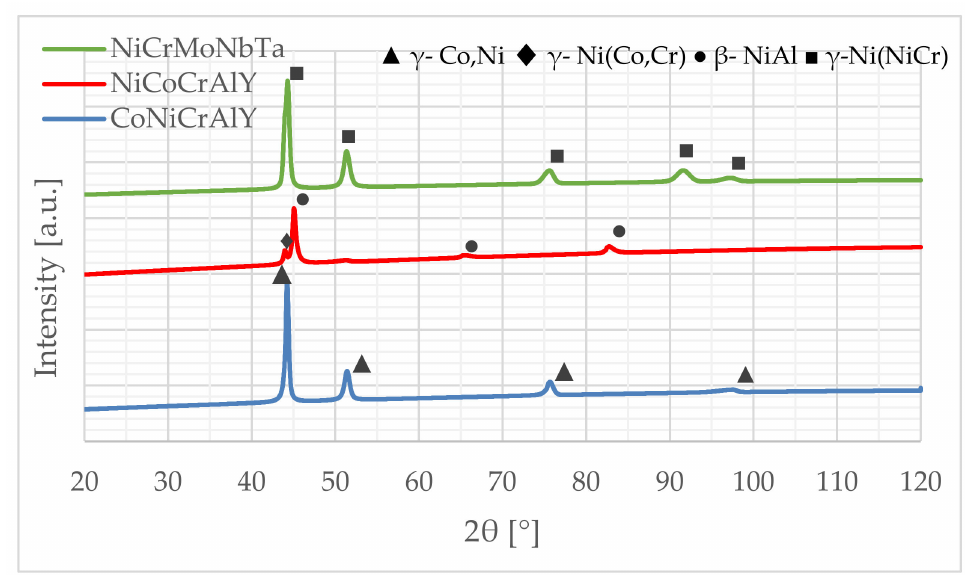
Figure 6. Comparison of phase composition of coatings, XRD.